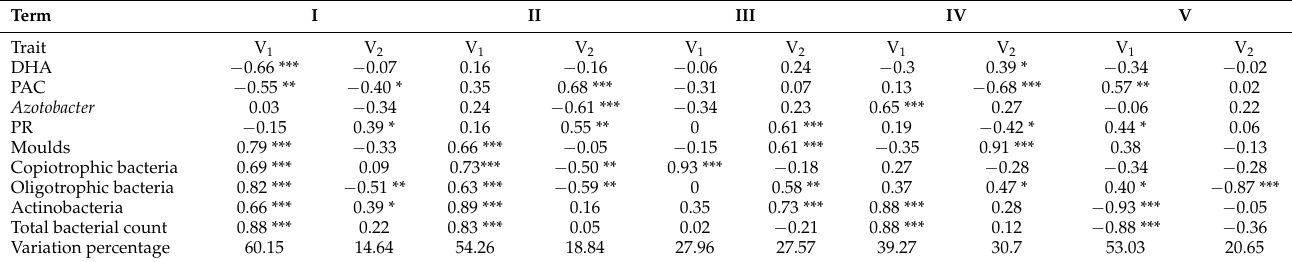
Table 5. Correlation coefficients between the first two canonical variates and the original traits at the five terms.